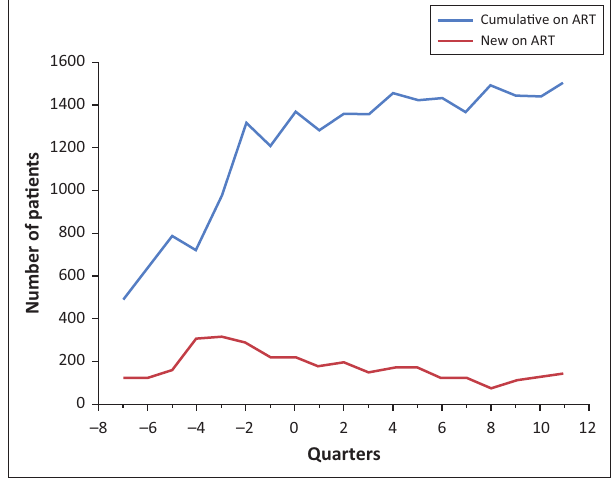
ART, antiretroviral therapy. FIGURE 3: Geita District Hospital patients, new and cumulative on antiretroviral therapy by